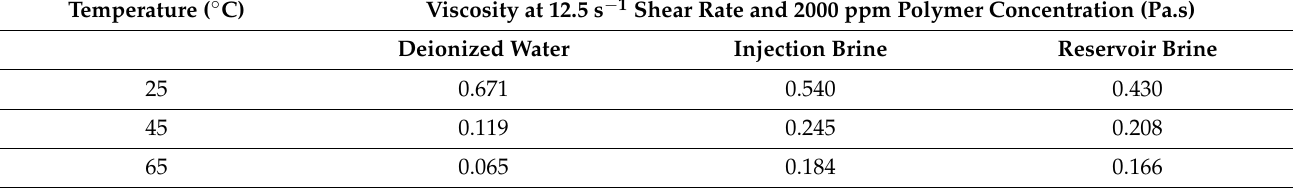
Table 8. Viscosity dependence of 2000 ppm polymer solutions at 12.5 s − 1 shear